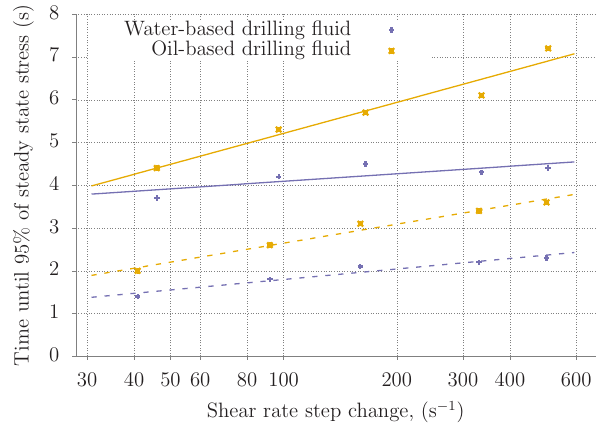
Figure 10: Time from stepping the shear rate and until the shear stress reaches 95% of the steady state value. Solid lines are asso- ciated with final, low shear rate of 5.1 s −1 while the dotted lines are associated with final, low shear rate of 10.2 s −1 .